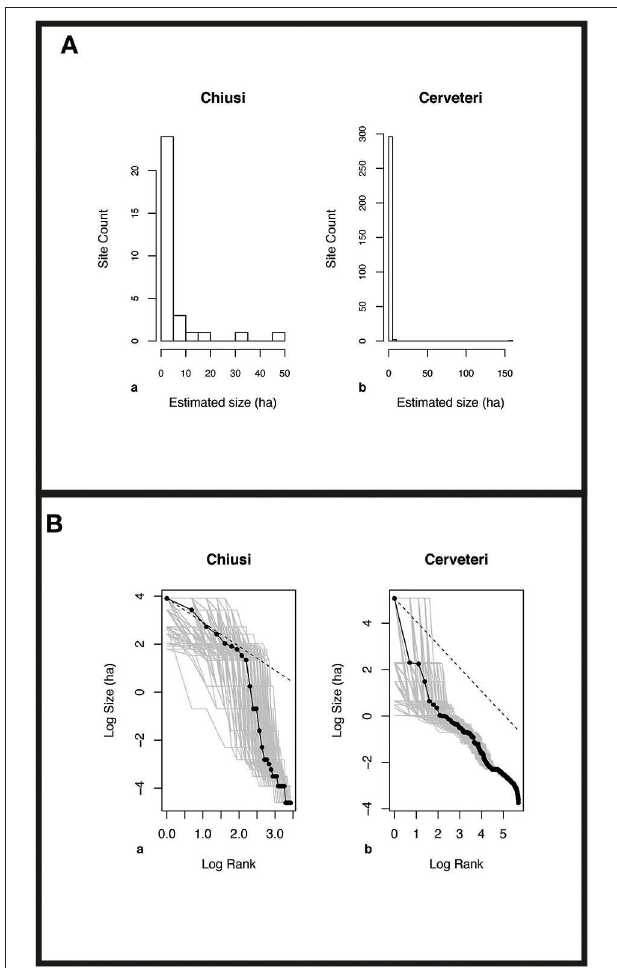
FIGURE 12 | (A) Presentation of new data for Chiusi (a) and Cerveteri (b) as histograms of site size frequency. (B) Presentation of new data for Chiusi (a) and Cerveteri (b) as Rank